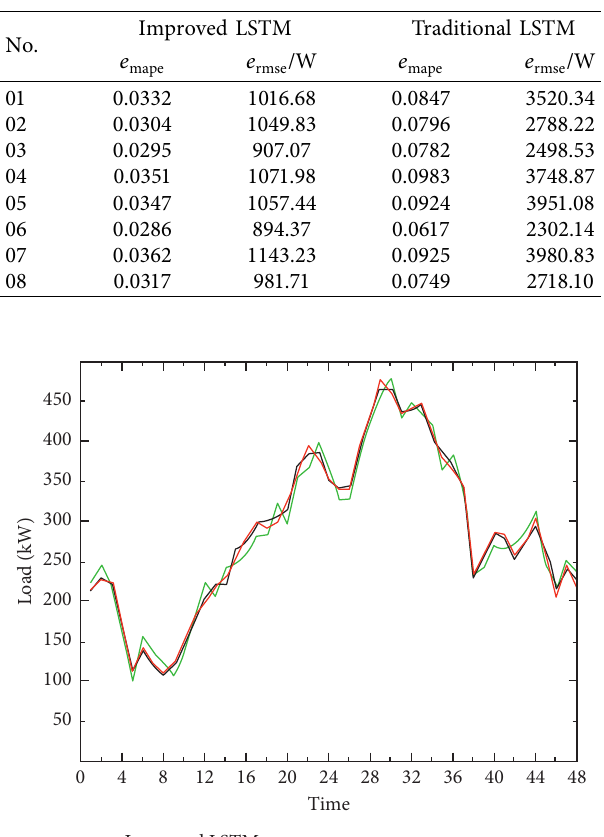
Table 2: Power prediction error.